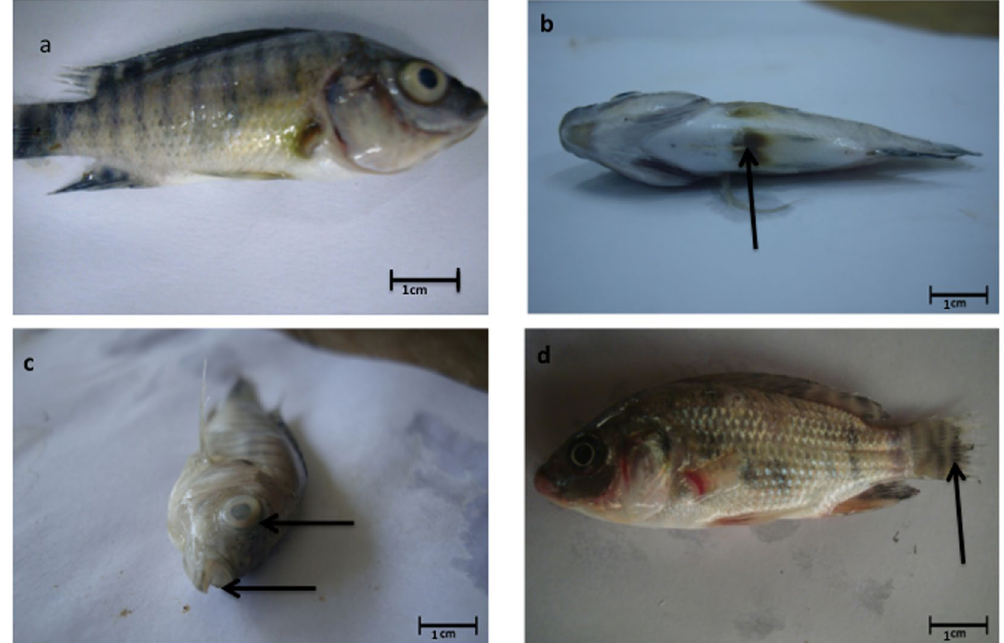
Figure 2. Artificially infected fish with E . faecalis isolate expressing distinct disease symptoms. ( a ) Control; ( b ) Swollen abdomen and hemorrhages at the base of pelvic fins; ( c ) Bilateral opacity and sign of asphyxiation; ( d ) Erosion in caudal